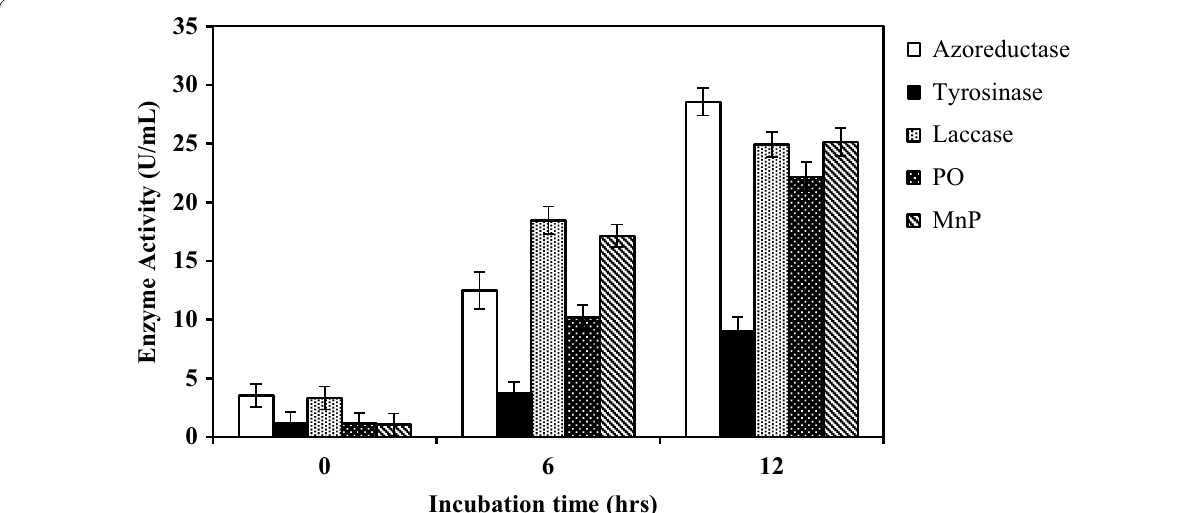
Fig. 4 Azoreductase, tyrosinase, laccase, phenol oxidase, and manganese peroxidase activity in initial to final stage of Reactive Red 31 decoloriza- tion at 35 °C